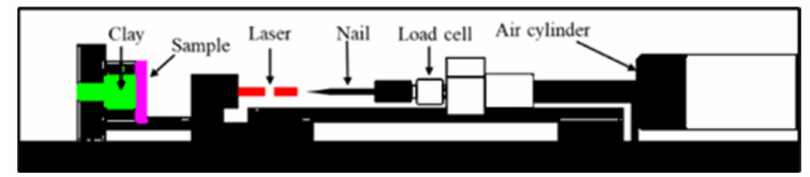
Figure 9. Puncture test